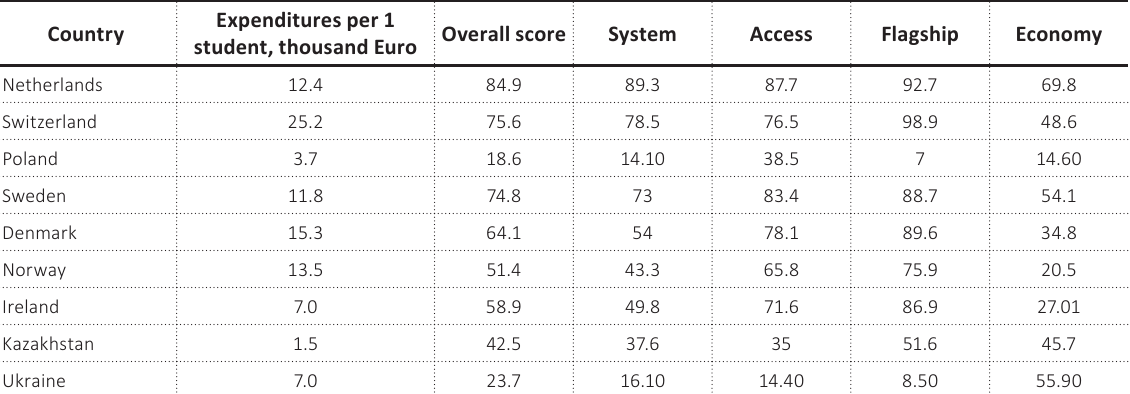
Table 4. Components of QS World University Rankings–2018